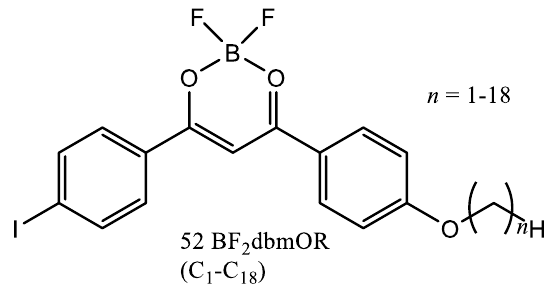
Figure 12. Structure of BF 2 dbmOR.